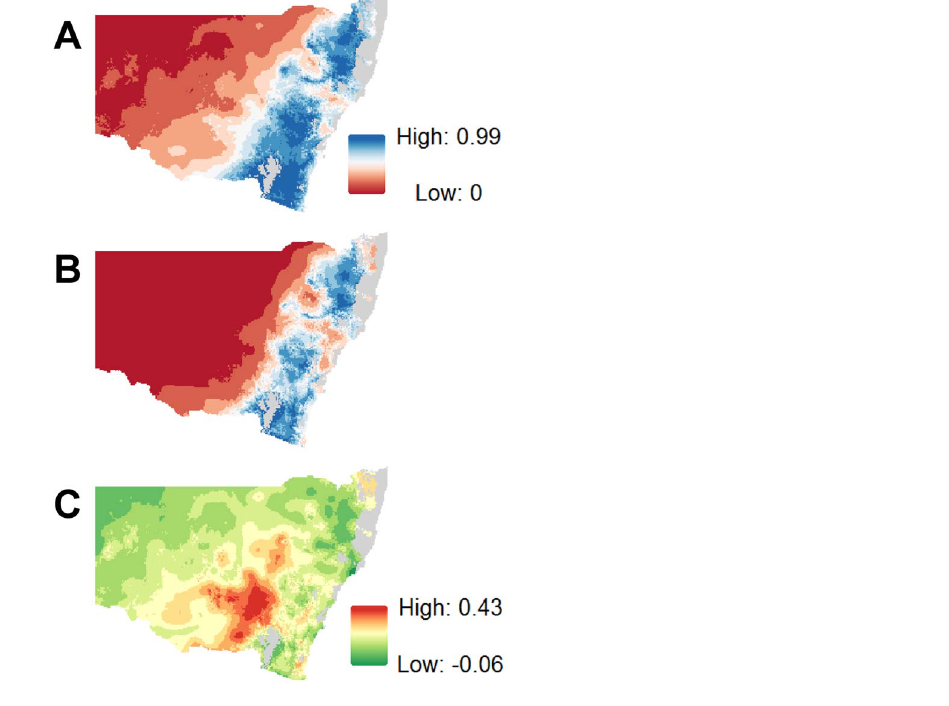
Fig. 3. Predicted RCV-A1 prevalence in New South Wales, Australia. (A) RCV-A1 prevalence for a period (2010–2012) of above average rainfall. (B) RCV-A1 prevalence for a period (2002–2004) of below average rainfall. (C) The grid-cell difference between predicted prevalence in a wet year and a dry